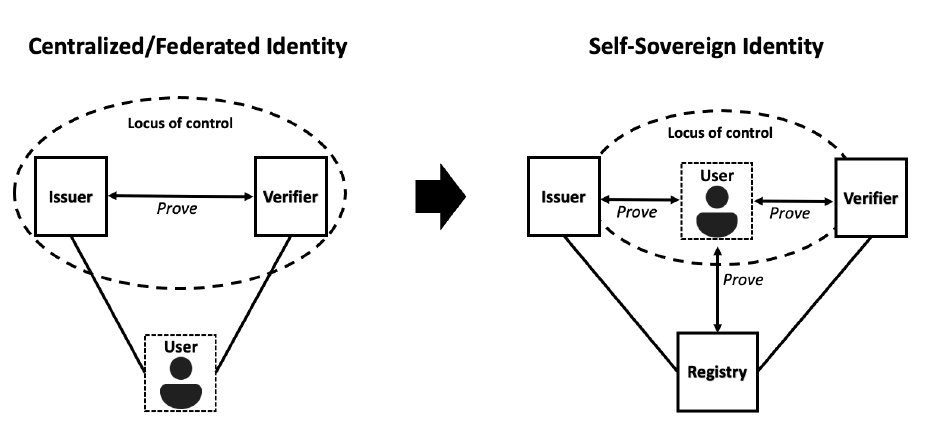
Figure 1. Shift of control with